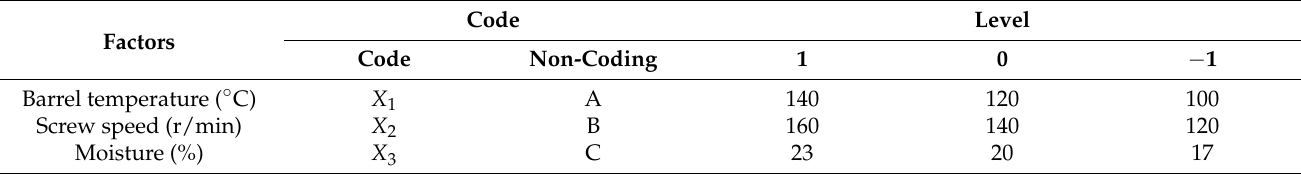
Table 1. Factor level coding table of single-factor extrusion treatment of RB. Code Level Factors Code